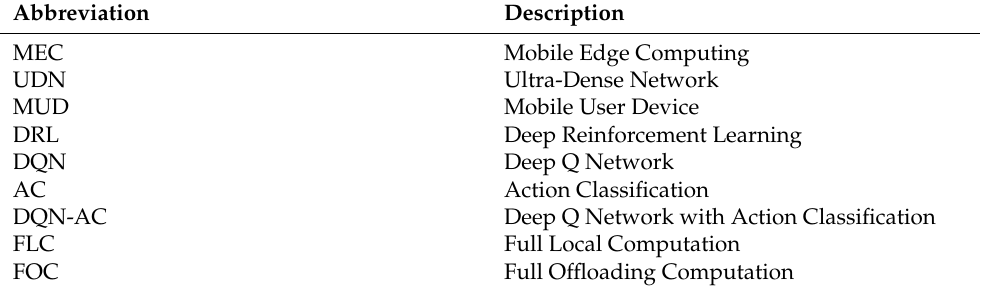
Table 2. List of abbreviations.